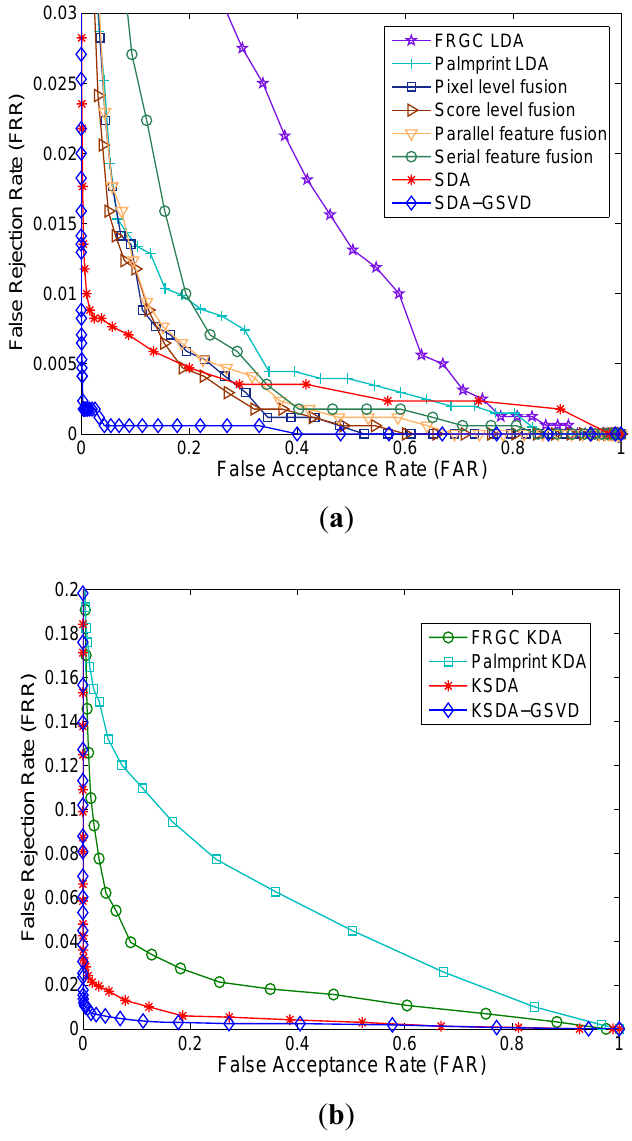
Figure 9. ROC curves of all compared methods on FRGC face and PolyU palmprint databases: ( a ) Linear methods; ( b ) Nonlinear methods.